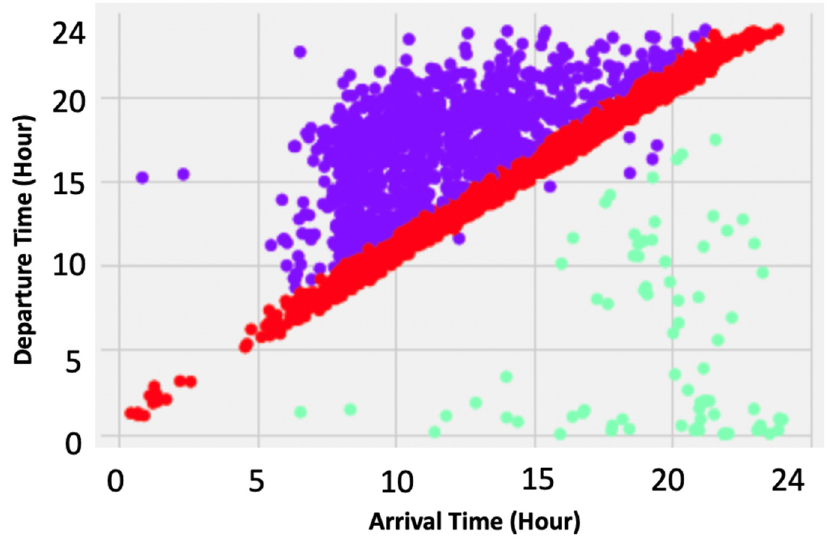
Figure 8. Cluster visualization for